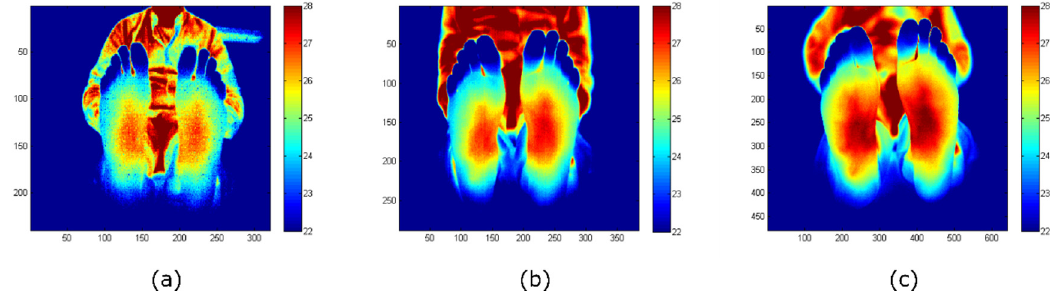
Figure 4. Feet images acquired with each camera: ( a ) ST; ( b ) TE-Q1; ( c ) INO IRXCAM-640. NU correction was applied to all the images to offer a clearer image. The images are color-coded indicating the temperature measurements in Celsius degrees (°C). The x - and y -axes represent the number of pixels of each sensor.